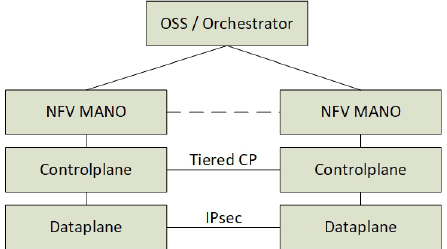
Figure 1. Extended east–west communication for Network Function Virtualization.